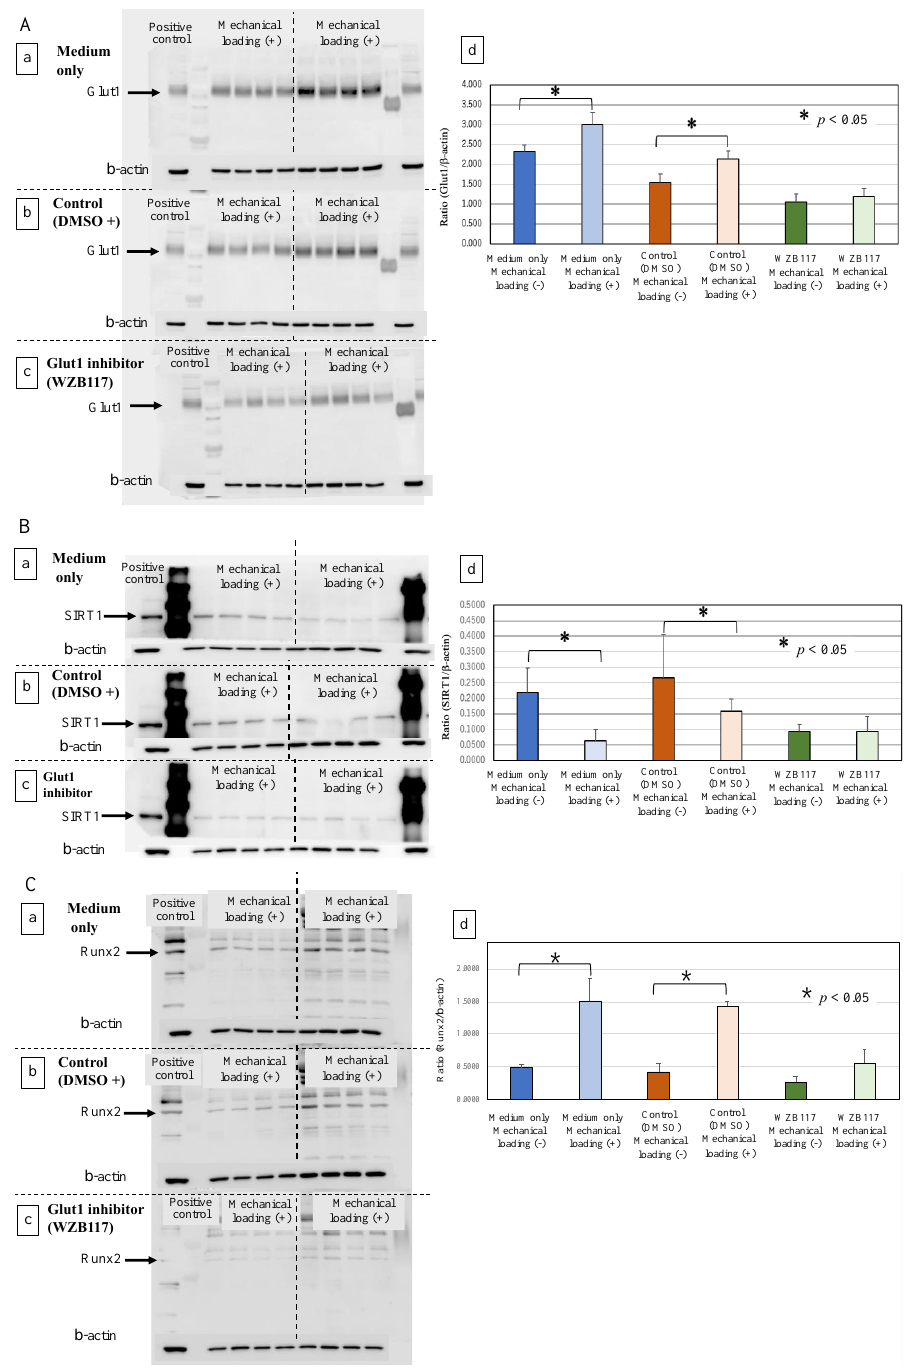
Figure 7. Effects of the Glut1 inhibitor on Glut-1, SIRT1, and Runx2 in osteoblasts. ( A ) The expression of Glut1 in mechanically loaded or non-loaded osteoblasts in the presence or absence of a Glut1 inhibitor (Western blot). ( a ) The culture medium only, ( b ) the control group (DMSO solution + culture medium), ( c ) the Glut1 inhibitor (WZB117)-treated group (10.0 μ M WZB117 in DMSO solution + culture medium), and ( d ) the expression relative to β -actin. ( B ) The expression of SIRT1 in mechanically loaded or non-loaded osteoblasts in the presence or absence of a Glut1 inhibitor (Western blot). ( a ) The culture medium only, ( b ) the control group (DMSO solution + culture medium), ( c ) the Glut1 inhibitor (WZB117)-treated group (10.0 μ M WZB117 in DMSO solution + culture medium), and ( d ) the expression relative to β -actin. ( C ) The expression of Runx2 in mechanically loaded or non-loaded osteoblasts in the presence or absence of a Glut1 inhibitor (Western blot). ( a ) The culture medium only, ( b ) the control group (DMSO solution + culture medium), ( c ) the Glut1 inhibitor (WZB117)-treated group (10.0 μ M WZB117 in DMSO solution + culture medium), and ( d ) the expression relative to β -actin. * p < 0.05.